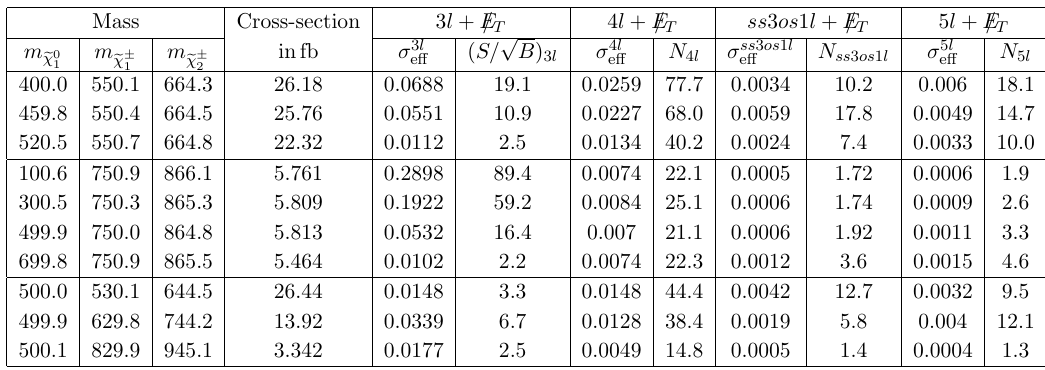
Table 8 . The masses and production cross-sections of all possible eweakino pairs for di(cid:11)erent BPs in the LMLS model are given. For the trilepton signal in each case we display the signi(cid:12)cance p ( S= B ). The corresponding (cid:27) e(cid:11) and total number of signal events (with negligible backgrounds) for each type of multilepton signal with n > 3 are also shown. Masses and cross-sections are in GeV and fb respectively.